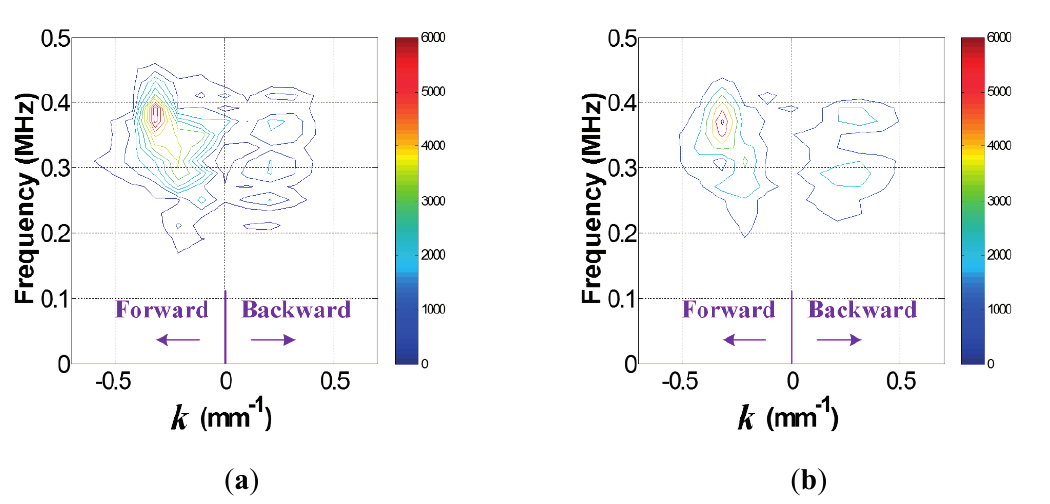
Figure 10. f-k domain plots obtained from the FE models ( a ) without and ( b ) with the